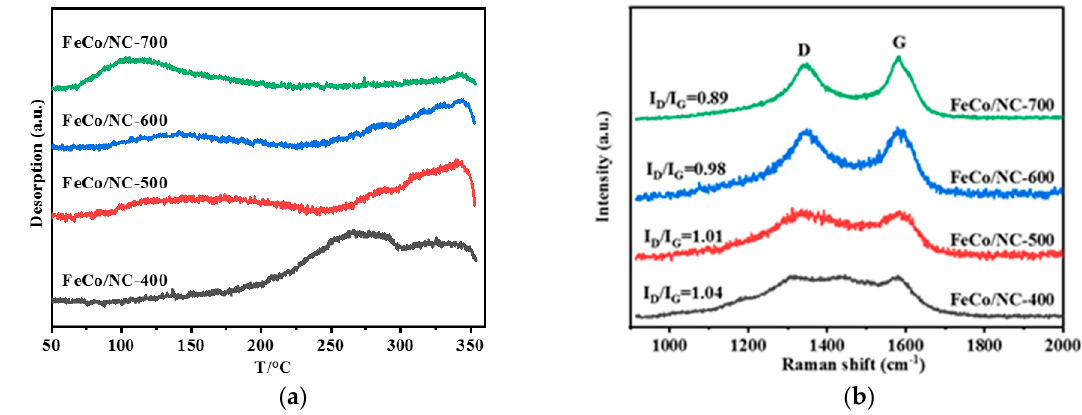
/ NC-T catalysts. 2 -TPD of FeCo